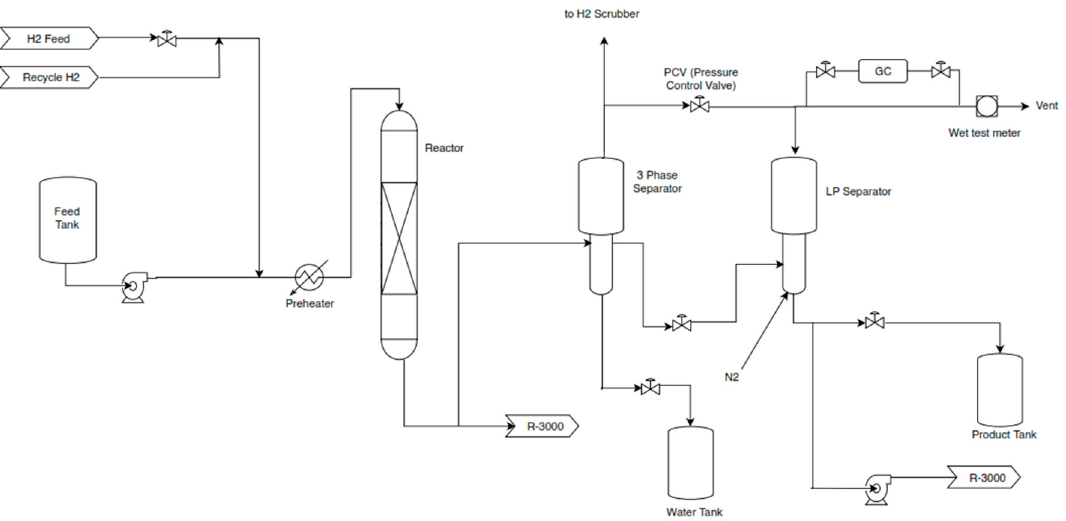
( a ) Dehydrogenation process. Figure 2. Cont